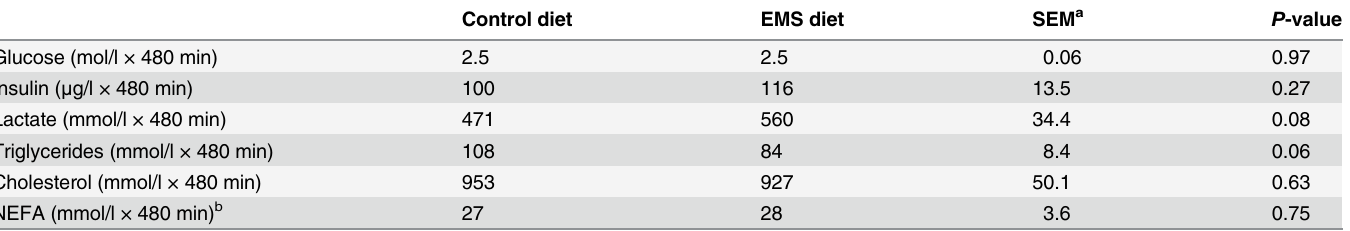
Table 2. Area-under-the-curve 0 – 480 min values during the meal tolerance test in pigs fed the enzymatically modified starch (EMS) diet or control